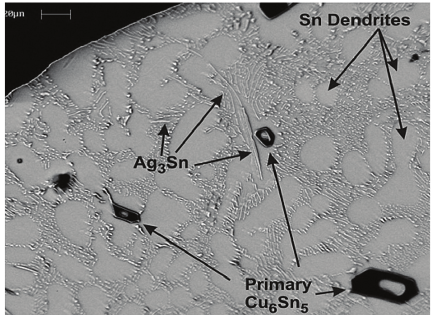
Figure 6: The microstructure of SnAgCu solder